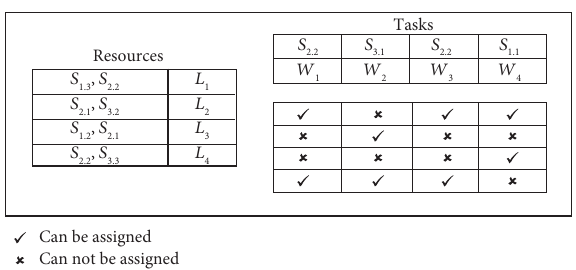
Figure 1: The relation matrix of resources-tasks